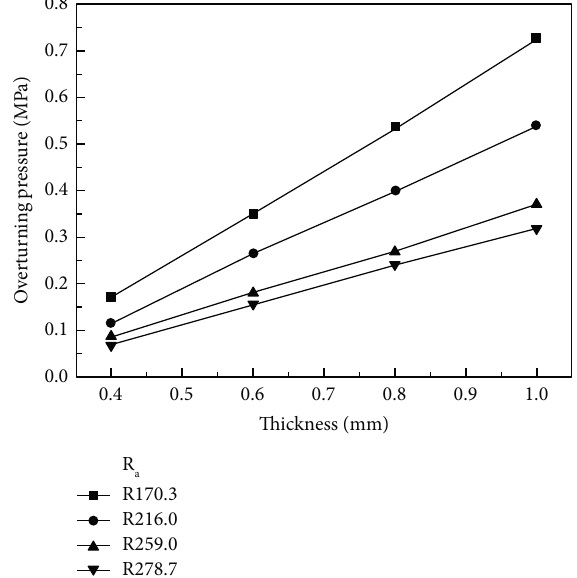
Figure 14: Efects of structural parameters on the overturning pressure.